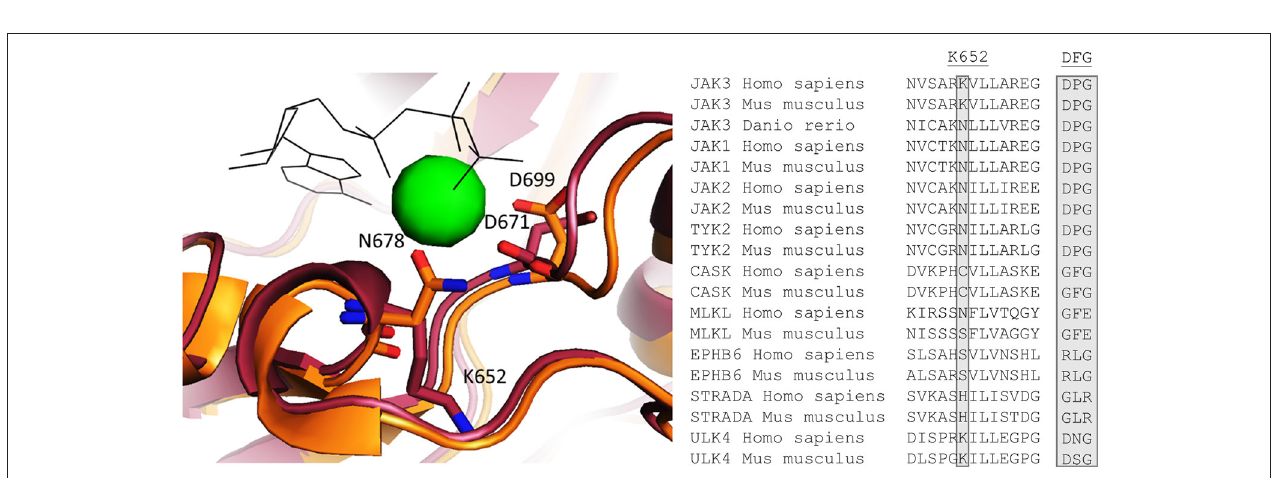
FIGURE 6 | Left : Homology model of JAK3 JH2 aligned with the crystal structure of JAK2 [PDB code: 4FVQ (25)]. JAK3 is shown in red and JAK2 in orange. ATP is shown as black shits and the Mg 2 + present in the JAK2 JH2 structure as a green sphere. Right : An alignment of human and mice sequences of JAKs and several other pseudokinases for Mg 2 + coordination, JAK3 K652, which is conserved as N in other JAKs, and is important for Mg 2 + coordination, is highlighted. Also the canonical DFG motif are compared and show variation between the pseudokinases.